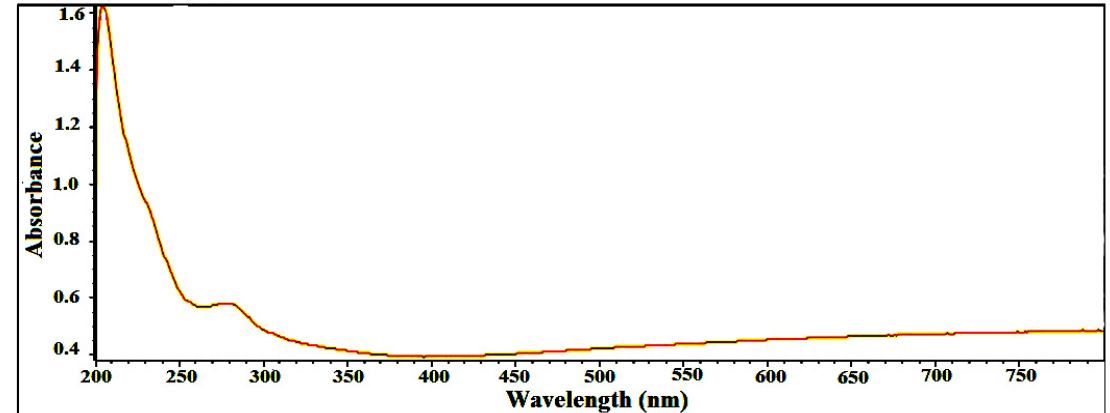
Figure 2. UV-Vis absorption spectra of TiO 2 NPs.